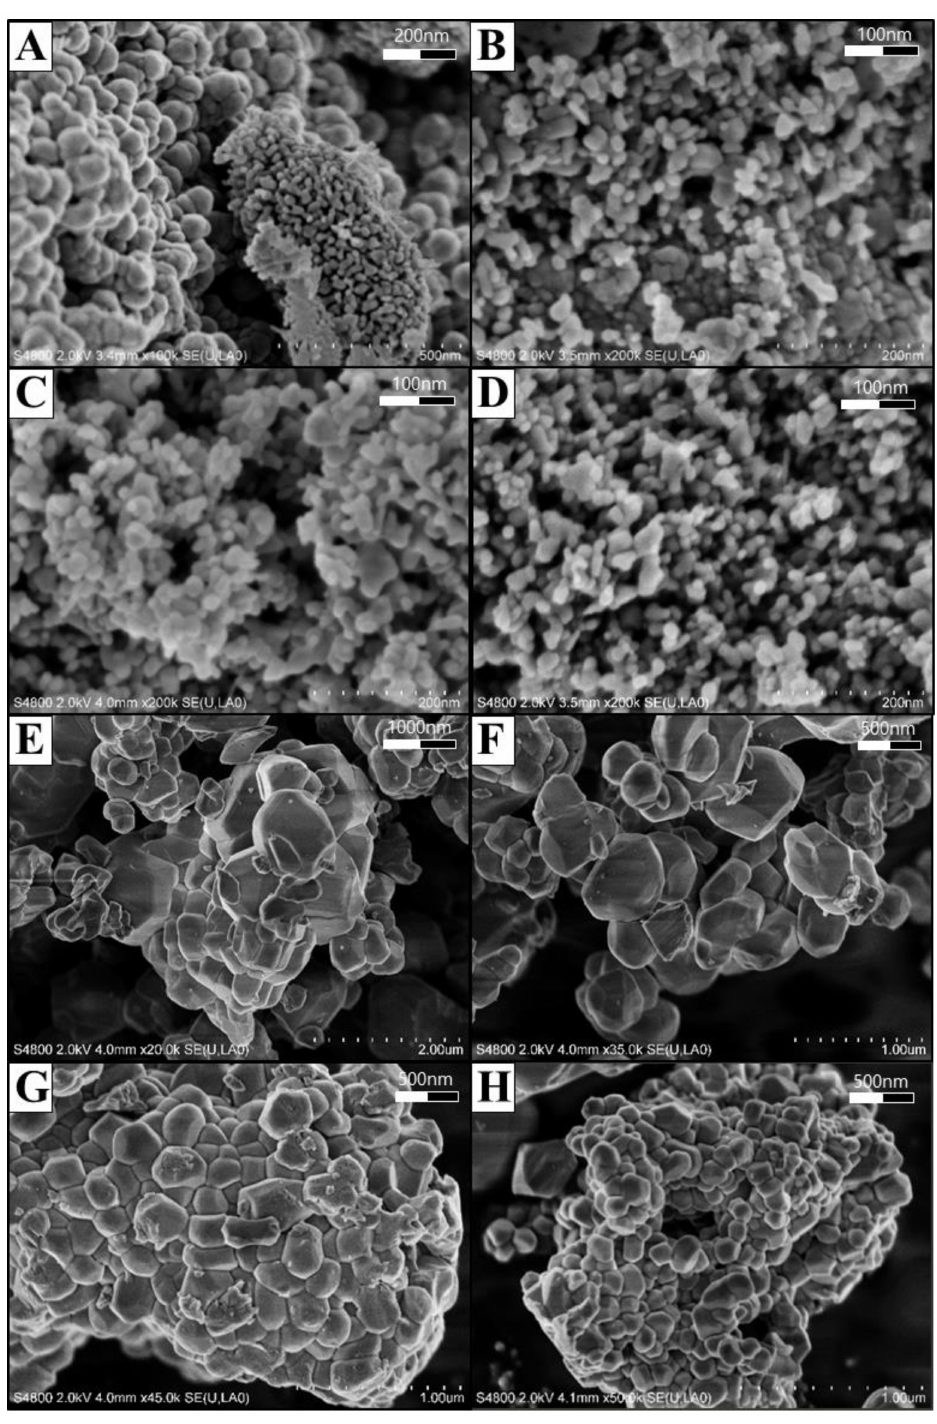
Figure 1. Field-emission scanning electron microscopy (SEM) images of the two di ff erent sizes of Co 3 O 4 nanoparticles (NPs). ( A ) 100,000 × and ( B – D ) 200,000 × for type A Co-NPs; ( E ) 20,000 × , ( F ) 35,000 × , ( G ) 45,000 × , and ( H ) 50,000 × for type B